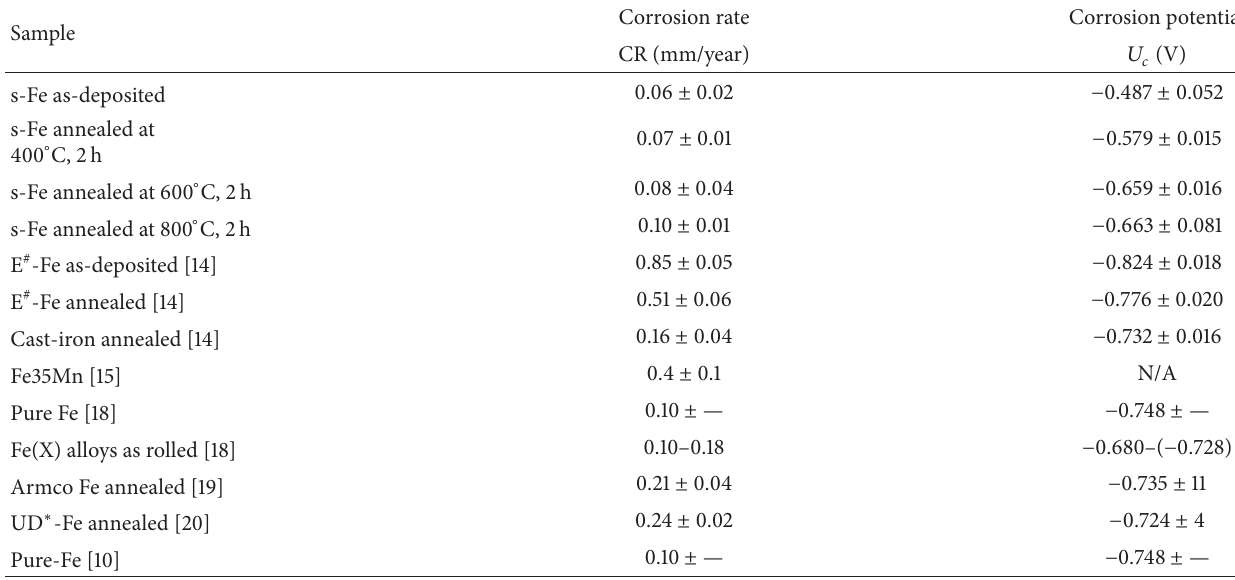
Table 3: Results of linear polarization corrosion measurements of s-Fe samples compared literature values.